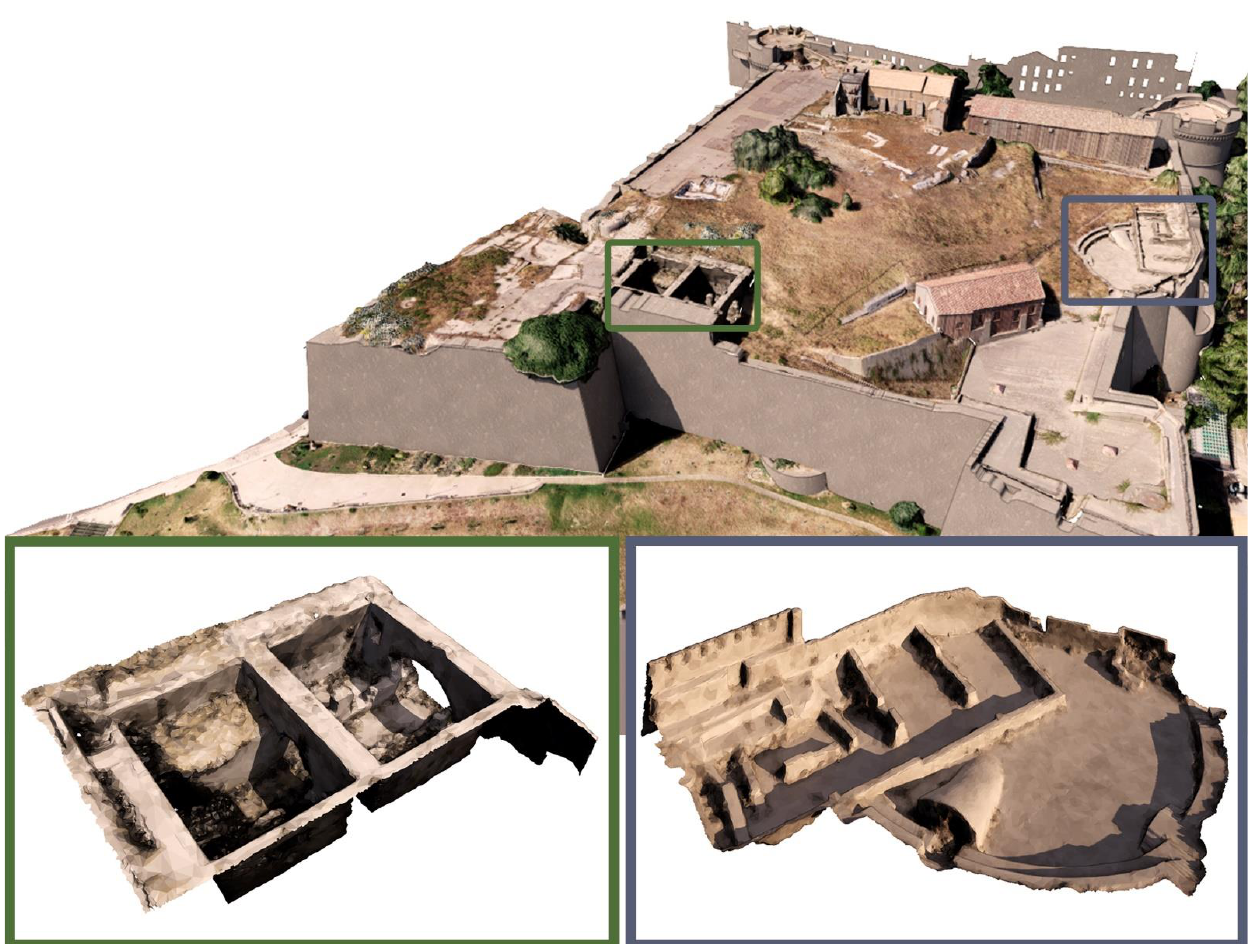
Figure 12. Results of Workflow B implementation.